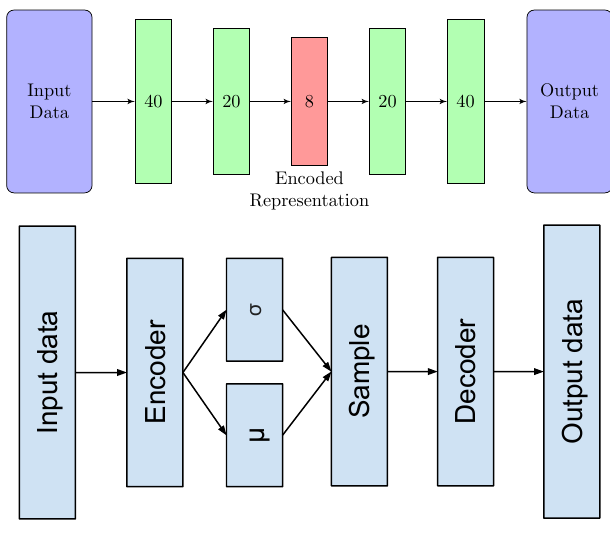
Figure 2 . Schematic of our AE (top) and a VAE